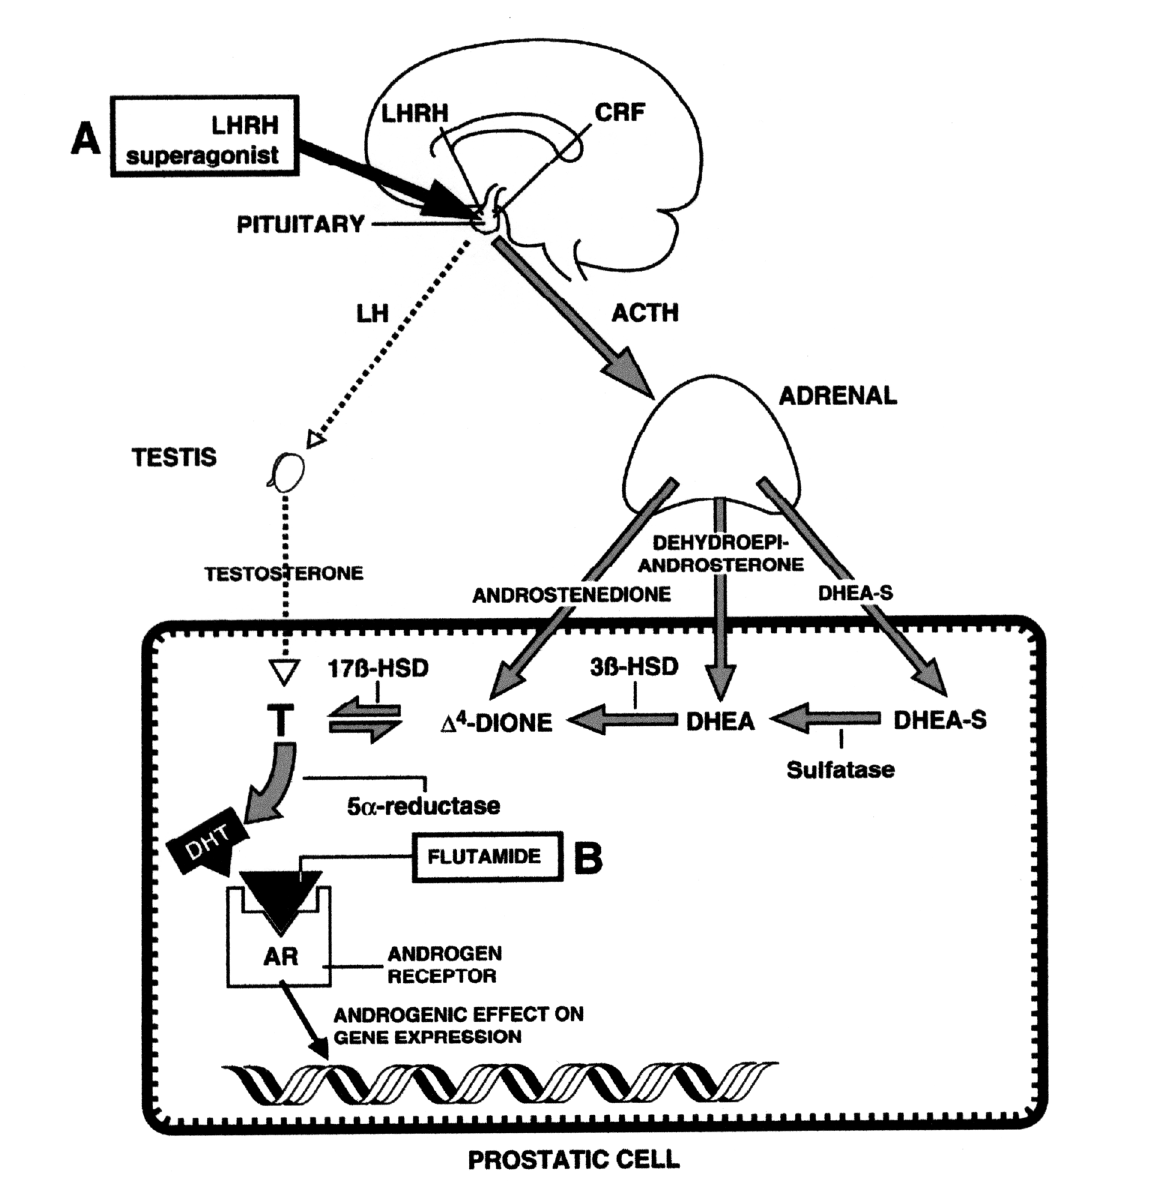
Figure 3 – Intracrine activity of the human prostate or biosynthetic steps involved in the formation of the active androgen dihydrotestosterone (DHT) from testicular testosterone as well as from the inactive adrenal precursors DHEA, DHEA-sulfate (DHEA- S), and 4-dione in human prostatic tissue. 17 ? -hydroxysteroid dehydrogenase; 3 ? -HSD = 3 ? -hydroxysteroid dehydrogenase/ ? 5 - ? 4 - isomerase. The widths of the arrows indicate the relative importance of the sources of DHT in the human prostate: 60% originating from the testes and 40% from the adrenals in 65-year-old men. The testis secretes testosterone (T) which is transformed into the more potent androgen DHT by 5 ? -reductase in the prostate. Instead of secreting T or DHT directly, the adrenal secretes very large amounts of DHEA and DHEA-sulfate (DHEA-S), which are transported in the blood to the prostate and other peripheral tissues. These inactive precursors are then transformed locally into the active androgens T and DHT. The enzymatic complexes DHEA sulfatase, 3 ? -HSD, 17 ? -HSD and 5 ? -reductase are all present in the prostatic cells, thus providing 40% of total DHT in this tissue. (From Labrie F: Androgen blockade in prostate cancer in 2002: major benefits on survival in localized disease. Mol Cell Endocrinol. 2002; 198: 77-